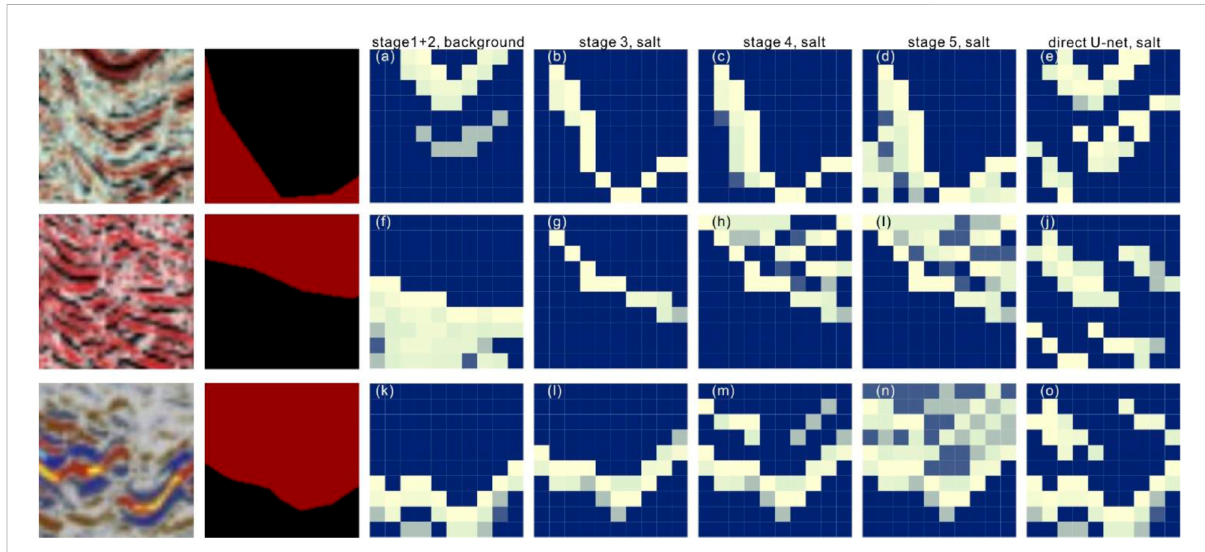
FIGURE 17 The obtained feature maps (from left to right, every column refers to the feature maps from different stage). Each line represents the feature map from one 2D seismic image and corresponding label; each column represents the same stage.